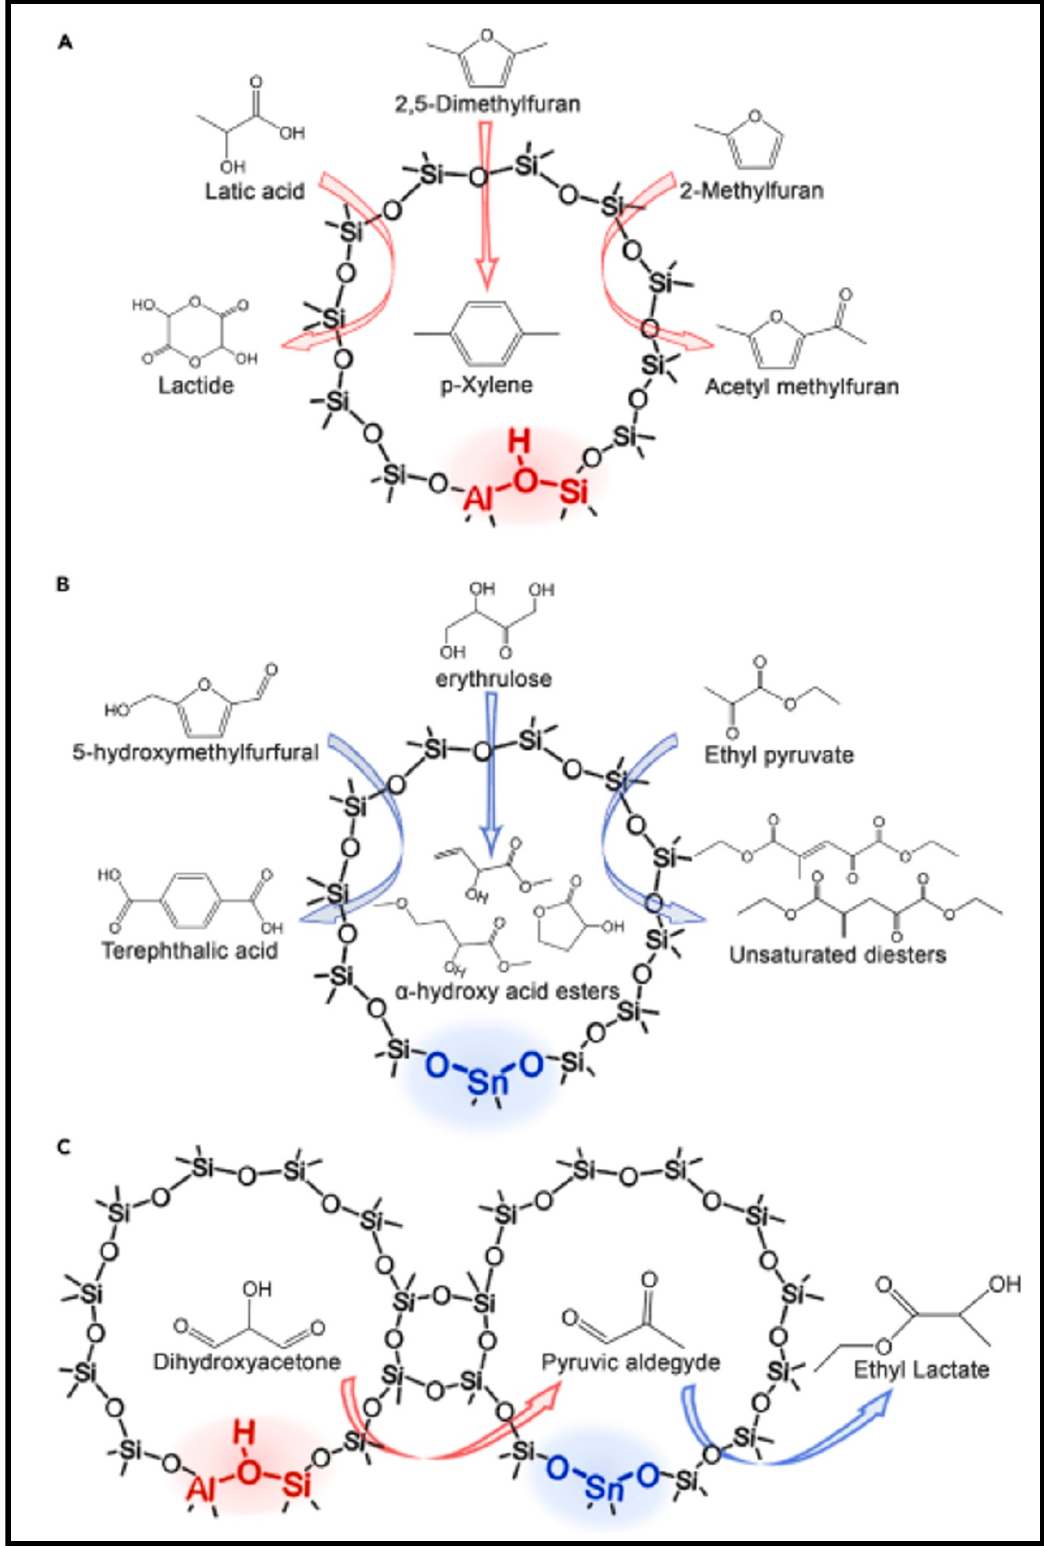
Figure 4. Various pathways of zeolite catalysts for biomass conversion with various active sites: ( A ) Brønsted acid site, ( B ) Lewis acid site, ( C ) multifunctional active sites [66].